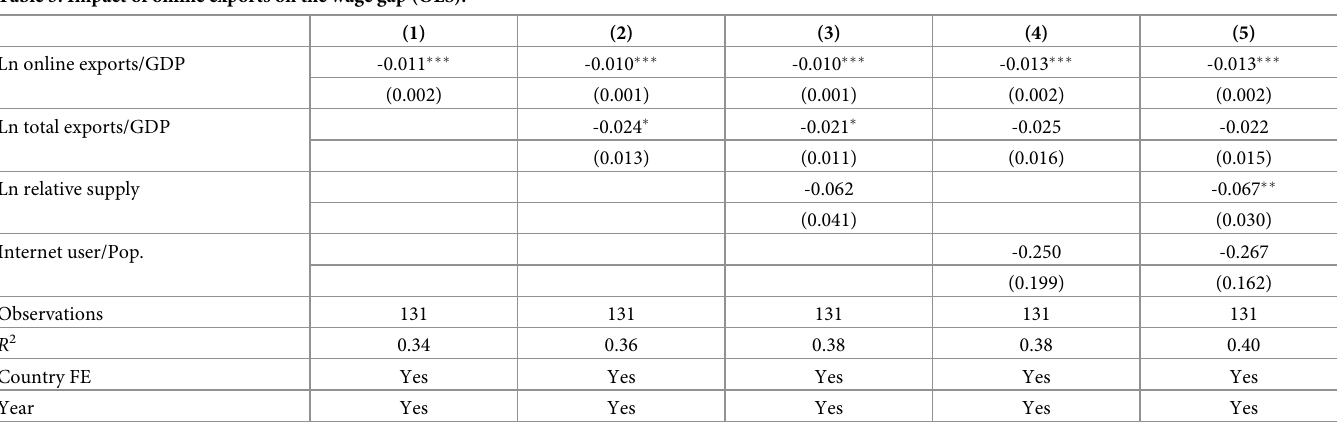
Table 3. Impact of online exports on the wage gap